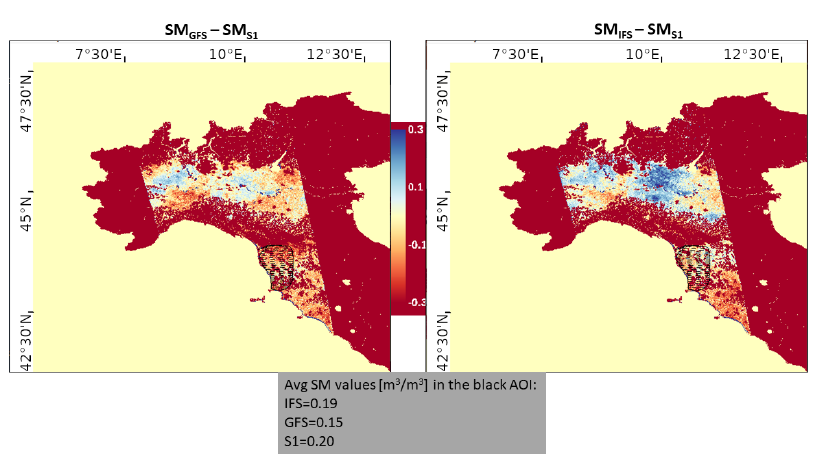
Figure 10. Difference maps between the IFS-driven SM experiment and the Sentinel-derived SM (SM IFS -SM S1 , on the right) compared to the difference between the GFS-driven SM experiment and the Sentinel-derived SM (SM GFS -SM S1 , on the left). The black area represent the Area Of Interest (AOI) on which mean values are